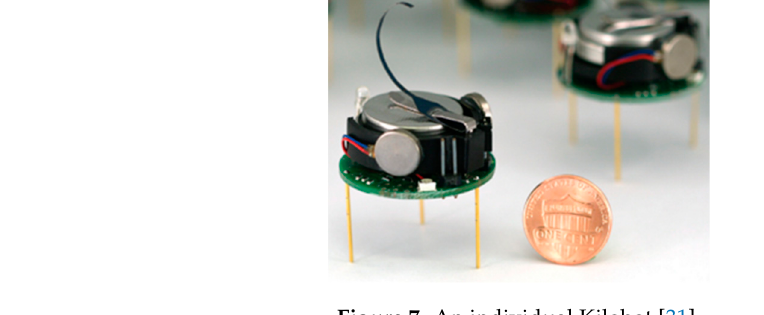
Figure 7. An individual Kilobot [31].